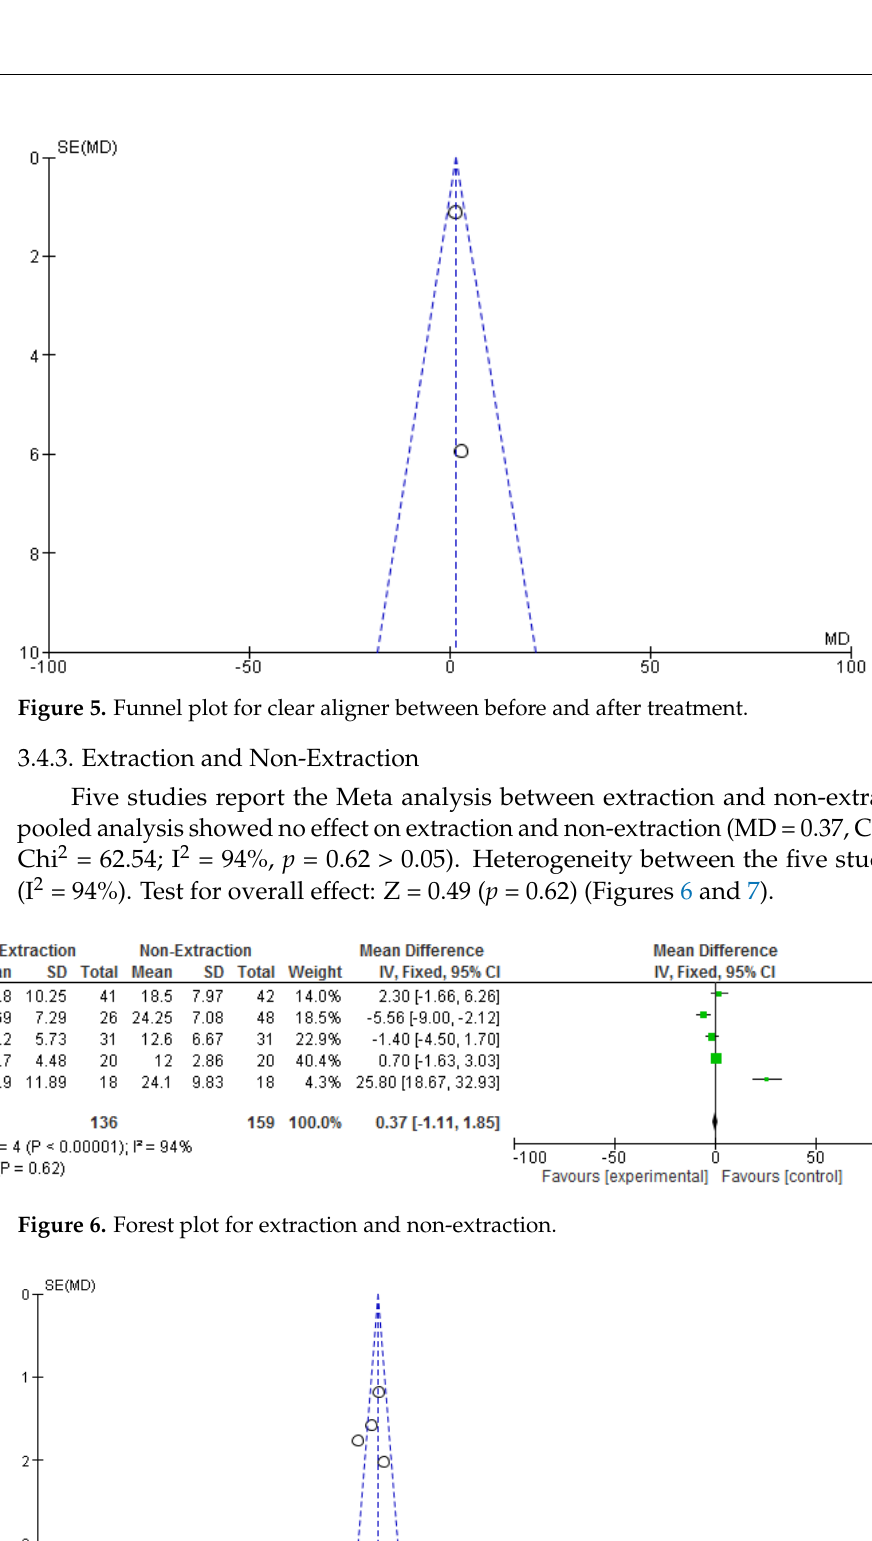
Figure 4. Forest plot for clear aligner between before and after treatment.